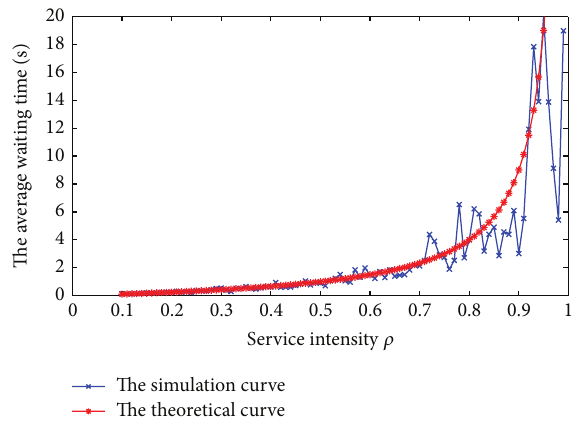
𝜌0 0.1 curveService intensity The simulation curve The theoretical Figure 7: Theoretical and simulation curves of the average waiting time in the queuing model without